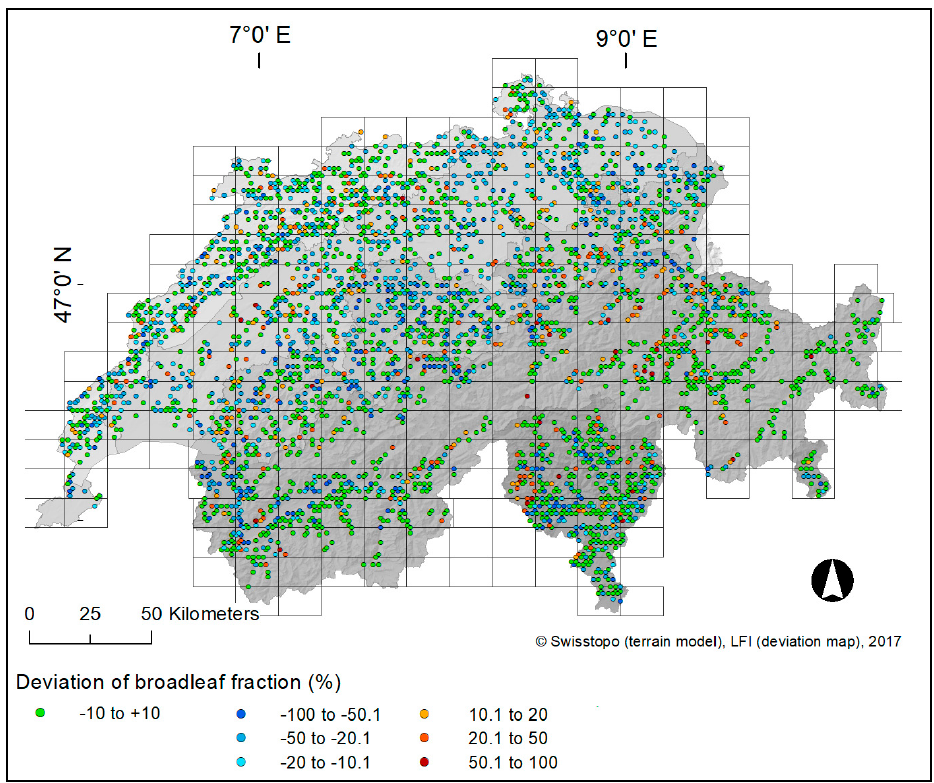
Figure 7. Deviation in predicted (tree type map) and observed (NFI image interpretation) broadleaved fraction in the IAs.